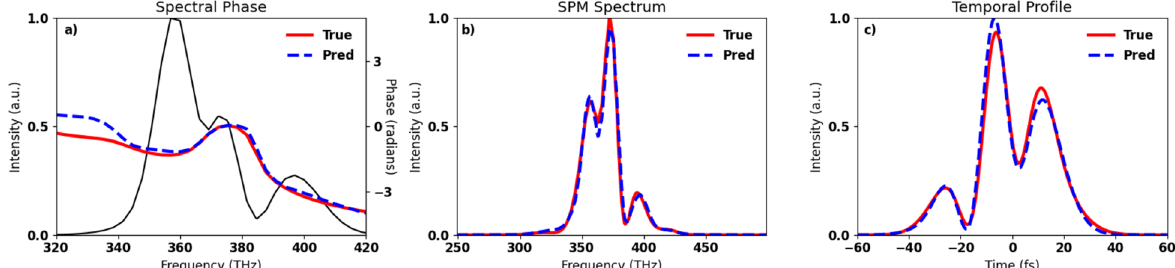
Figure 2. An example of a randomly generated simulated laser pulse used to train the neural network. (A) A randomly generated spectrum (black) centered on 374 THz along with the randomly generated phase (red) and the reconstructed initial phase (dashed blue). (B) GNLSE simulations based from the reconstructed initial pulse(dashed blue) and the true initial pulse (red). (C) Temporal profiles of the reconstructed pulse(dashed blue) and the true temporal profile (red).